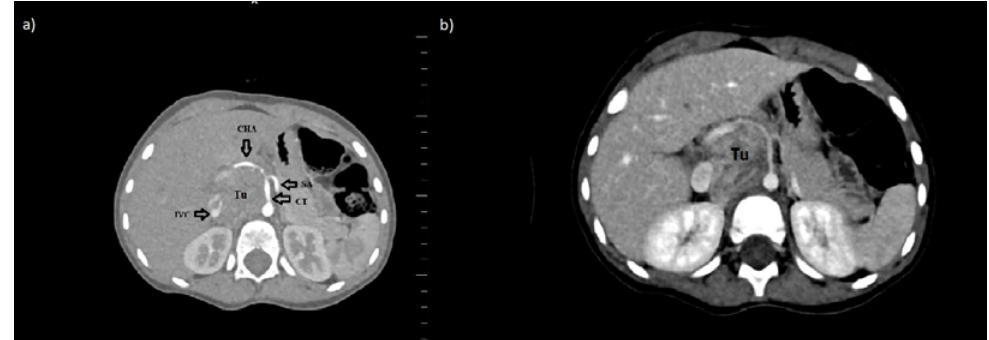
Figure 1. Axial abdominal computed tomography scan in venous phase showed a retroperitoneal tumor in our patient a diagnosis ( a ) and after two courses of chemotherapy with Vepeside and Carboplatin ( b ). Abbreviations: CT—coeliac